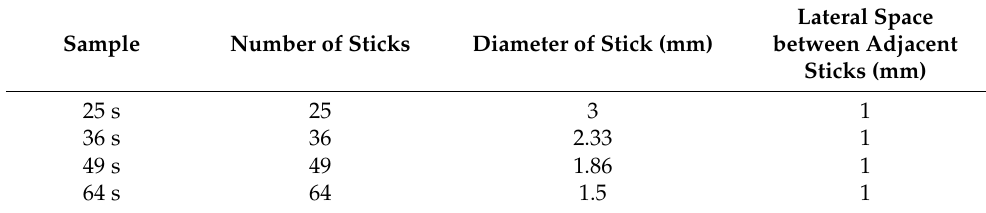
Figure 4. Supported plate–stick mixed design. ( a ) Supported plate–stick mixed design. The objects in the middle (molds) are inserted into the object on the left (support) and covered by the object on the right (cap) after injection of sol. The space (tolerance) between a mold and the support is 0.25 mm; the tolerance between the cap and the support is also 0.25 mm. ( b ) Side view of the overall assembly, with the cap ready to slide along the support–mold assembly. The stick-shaped parts between two adjacent plates are 2mm-long while the plates are 1mm-thick. The empty spaces below and above the plate–stick combination are both 5mm-deep. Other dimensions are identical to the supported stick design. Table 6. Characteristics of the different samples produced from the supported plate–stick mixed design (Figure 4a).